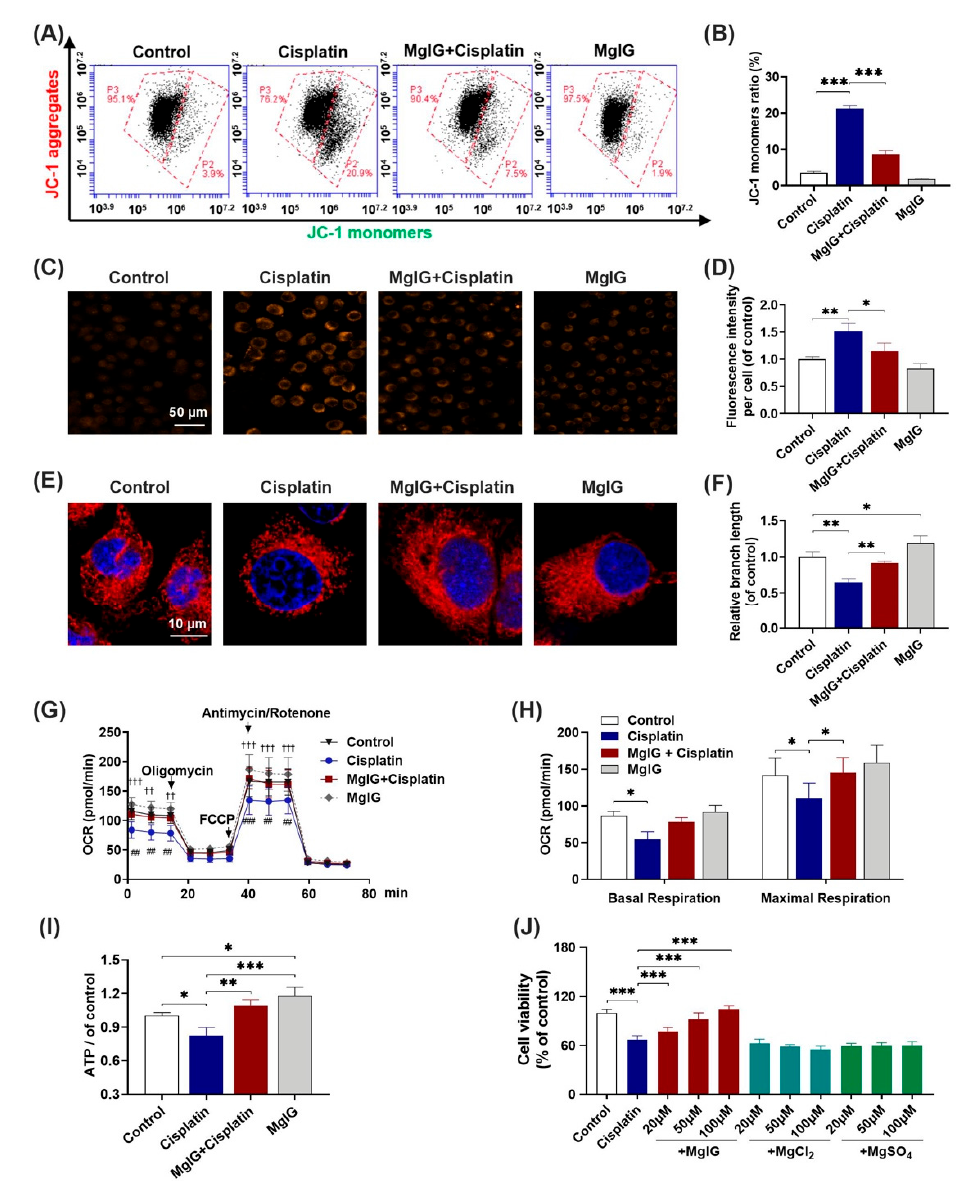
Figure 3. MgIG notably alleviates cisplatin-induced mitochondrial dysfunction. ( A , B ) The representative images of JC-1 staining of HK-2 cells evaluated by a flow cytometer, n = 4. ( C , D ) Representative images showing the mitochondrial ROS of HK-2 cells after staining with MitoSOX and quantitative analysis, n = 3. (Scale bar = 50 µ m). ( E , F ) Representative images showing the mitochondrial morphology of HK-2 cells after staining with MitoTracker ® Deep Red and quantitative results, n = 3. (Scale bar = 10 μ m.) ( G , H ) Representative traces of the measurement of oxygen consumption rate (OCR), n = 5. Oligomycin, FCCP, and antimycin/rotenone were administrated at the indicated time points. The production of basal and maximal respiration was determined according to the OCR values. Co-incubation with MgIG suppressed cisplatin-induced depolarization of the mitochondrial membrane potential, mtROS production, OCR decrease, and morphological abnormalities. †† p < 0.01, ††† p < 0.001, the cisplatin group versus the control group. ## p < 0.01, ### p < 0.001, the cisplatin group versus the MgIG + cisplatin group. ( I ) The intracellular ATP level. MgIG co-treatment reversed cisplatin-induced ATP production decrease in HK-2 cells. ( J ) The cell viability evaluated by CCK-8, n = 5. Mg salts offered no protection from proliferation inhibition caused by cisplatin in HK-2 cells. The data are presented as the mean ± SD. * p < 0.05, ** p < 0.01, *** p < 0.001.